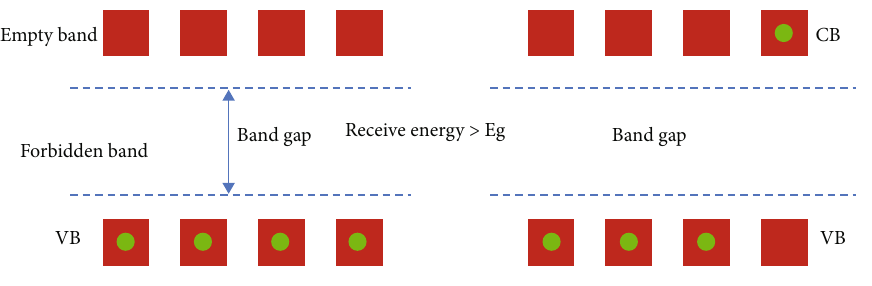
Figure 1: Energy band theory schematic.